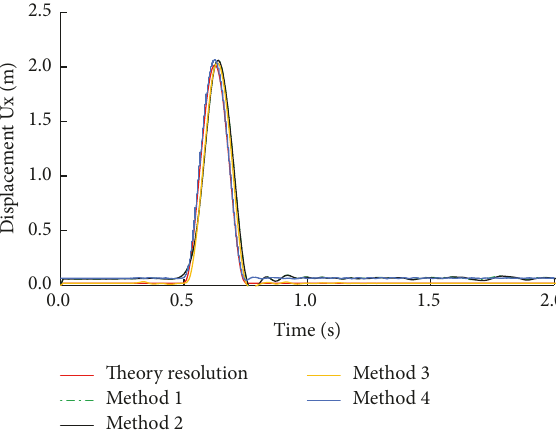
Figure 14: Z component displacement of Point B.